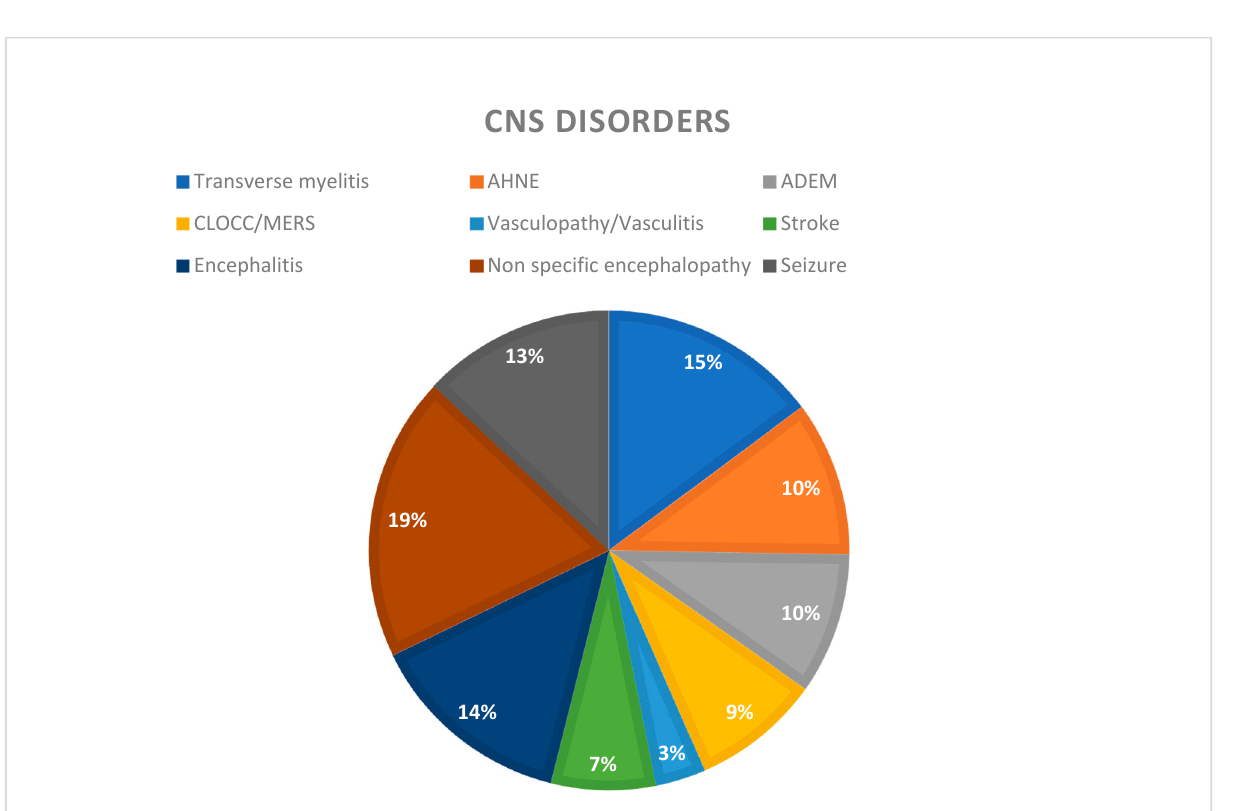
Figure 2. Pie chart showing distribution of various CNS disorders post COVID-19. A CSF protein level greater than 45 mg/dL was considered elevated. This was noted in patients with AHNE (100%), transverse myelitis (75%), encephalitis (71%) and ADEM (70%). The CSF protein in patients with AHNE showed a significant elevation ( p -value of 0.01) in all of the nine patients who underwent CSF analysis. A cell count of greater than 5 cells/mm 3 is considered to be elevated; this was most commonly seen in patients with transverse myelitis (69%) and ADEM (40%). Patients with transverse myelitis showed statistically significant elevation in their CSF cell count ( p -value of 0.001); that is 9 out of 13 patients (Table 2).